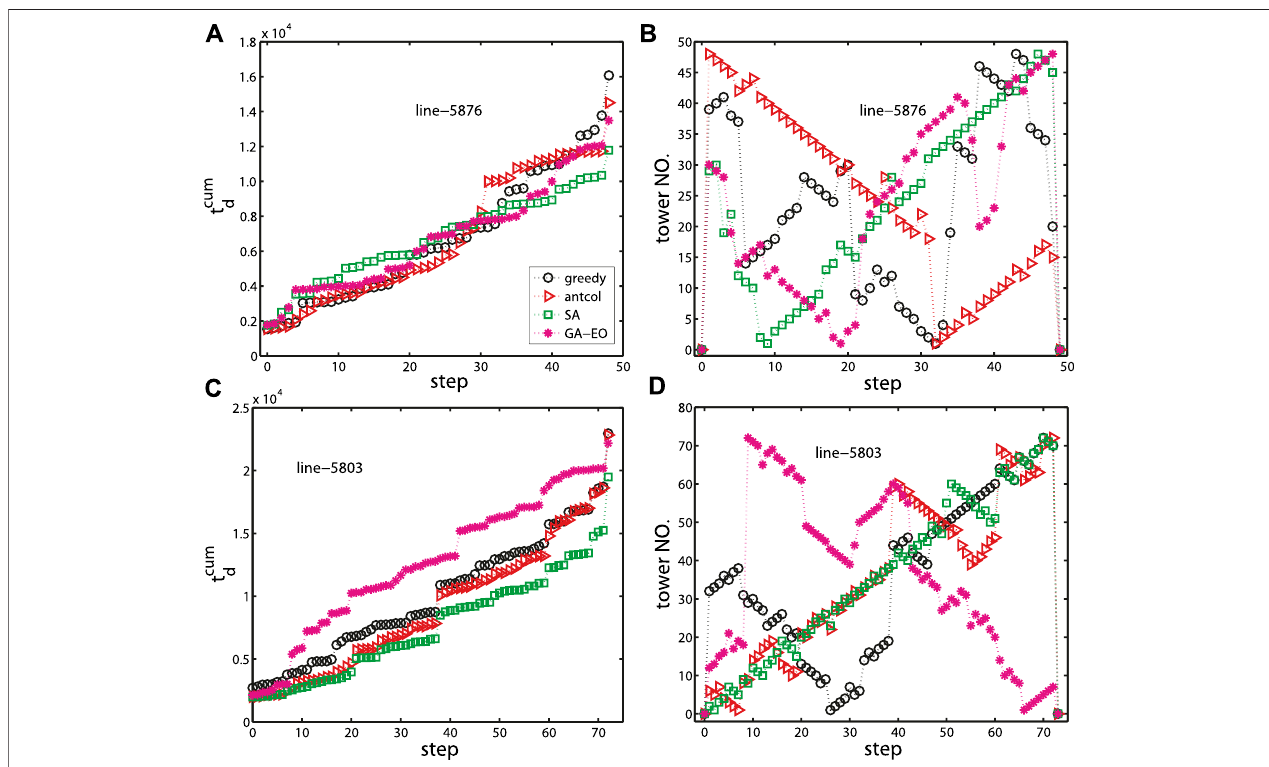
FIGURE3| (coloronline)Underthe four algorithms (greedy, antcol, SA, and GA-EO); (A,C) thecumulativedrivingtime for asingle inspectionteam tocomplete the task; (B,D) the optimal inspection path. 0 in tower NO. represents the of fi ce, and tower NO means the tower number is to be inspected at that step. (A,B) line-5876. (C,D) Line-5803. The perturbation parameter p = 0.05 for the greedy